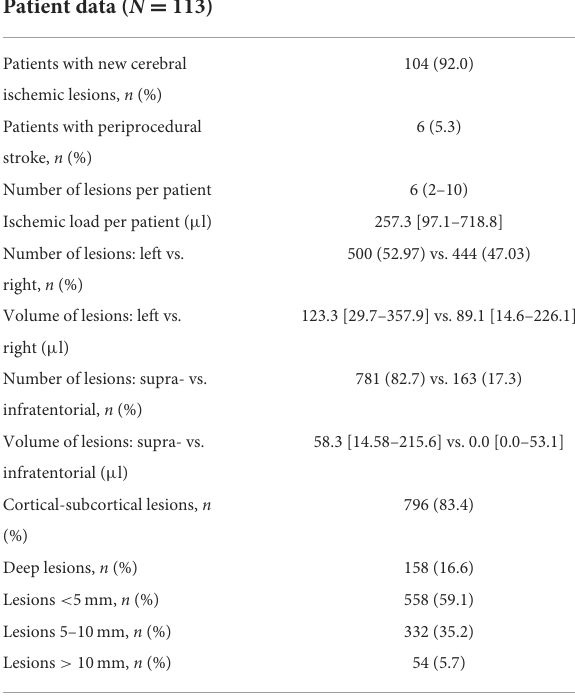
TABLE 3 Results of postprocedural assessment with